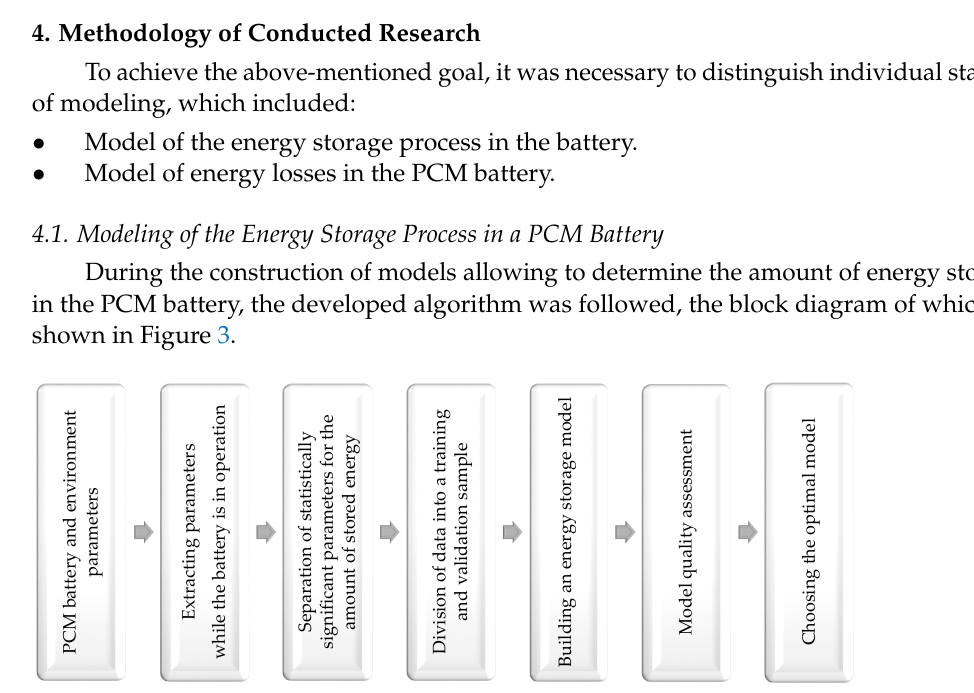
Figure 3. Block diagram of the model for estimating the amount of energy stored in the battery.